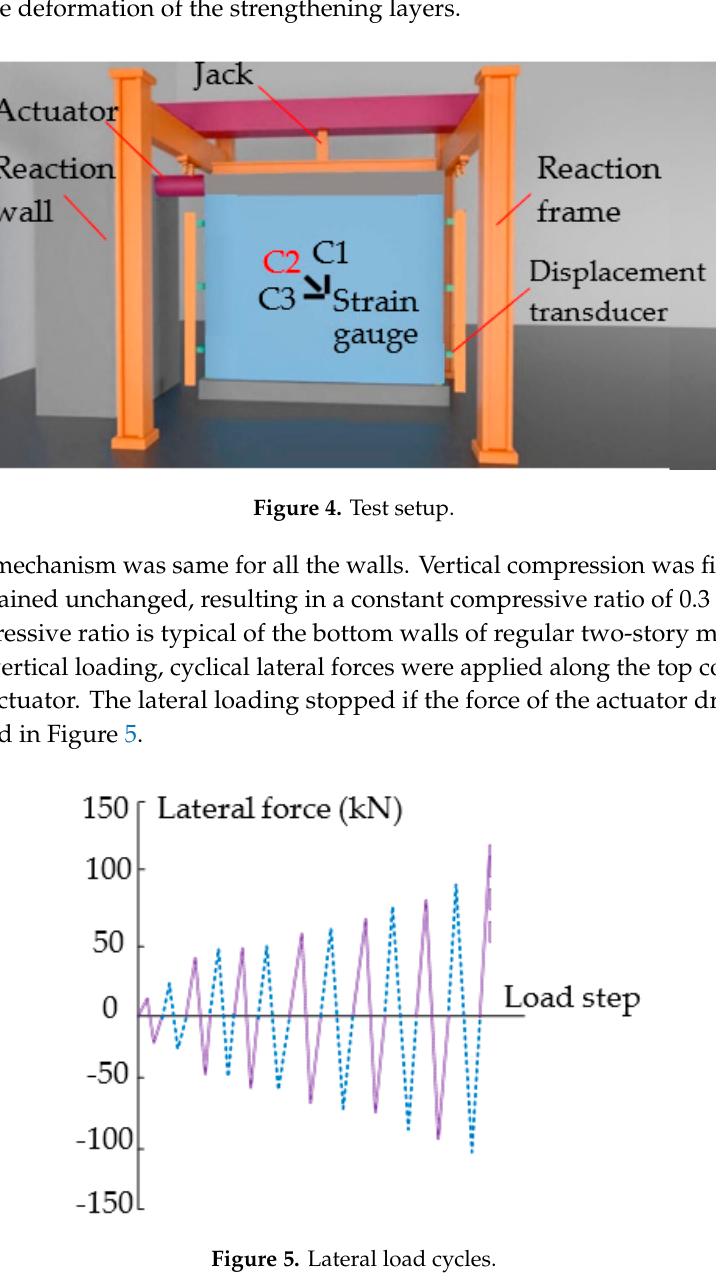
Figure 3. Construction of the strengthening layers: ( a ) The UHPClayer; ( b ) The reinforced polymer mortar layer.